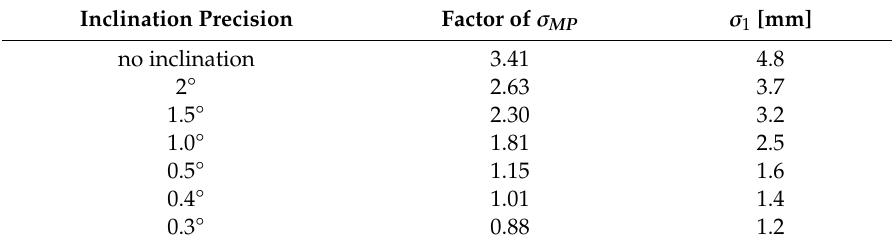
Table 1. Improvement of the along-tube positional precision of characteristic point C as a function of inclination